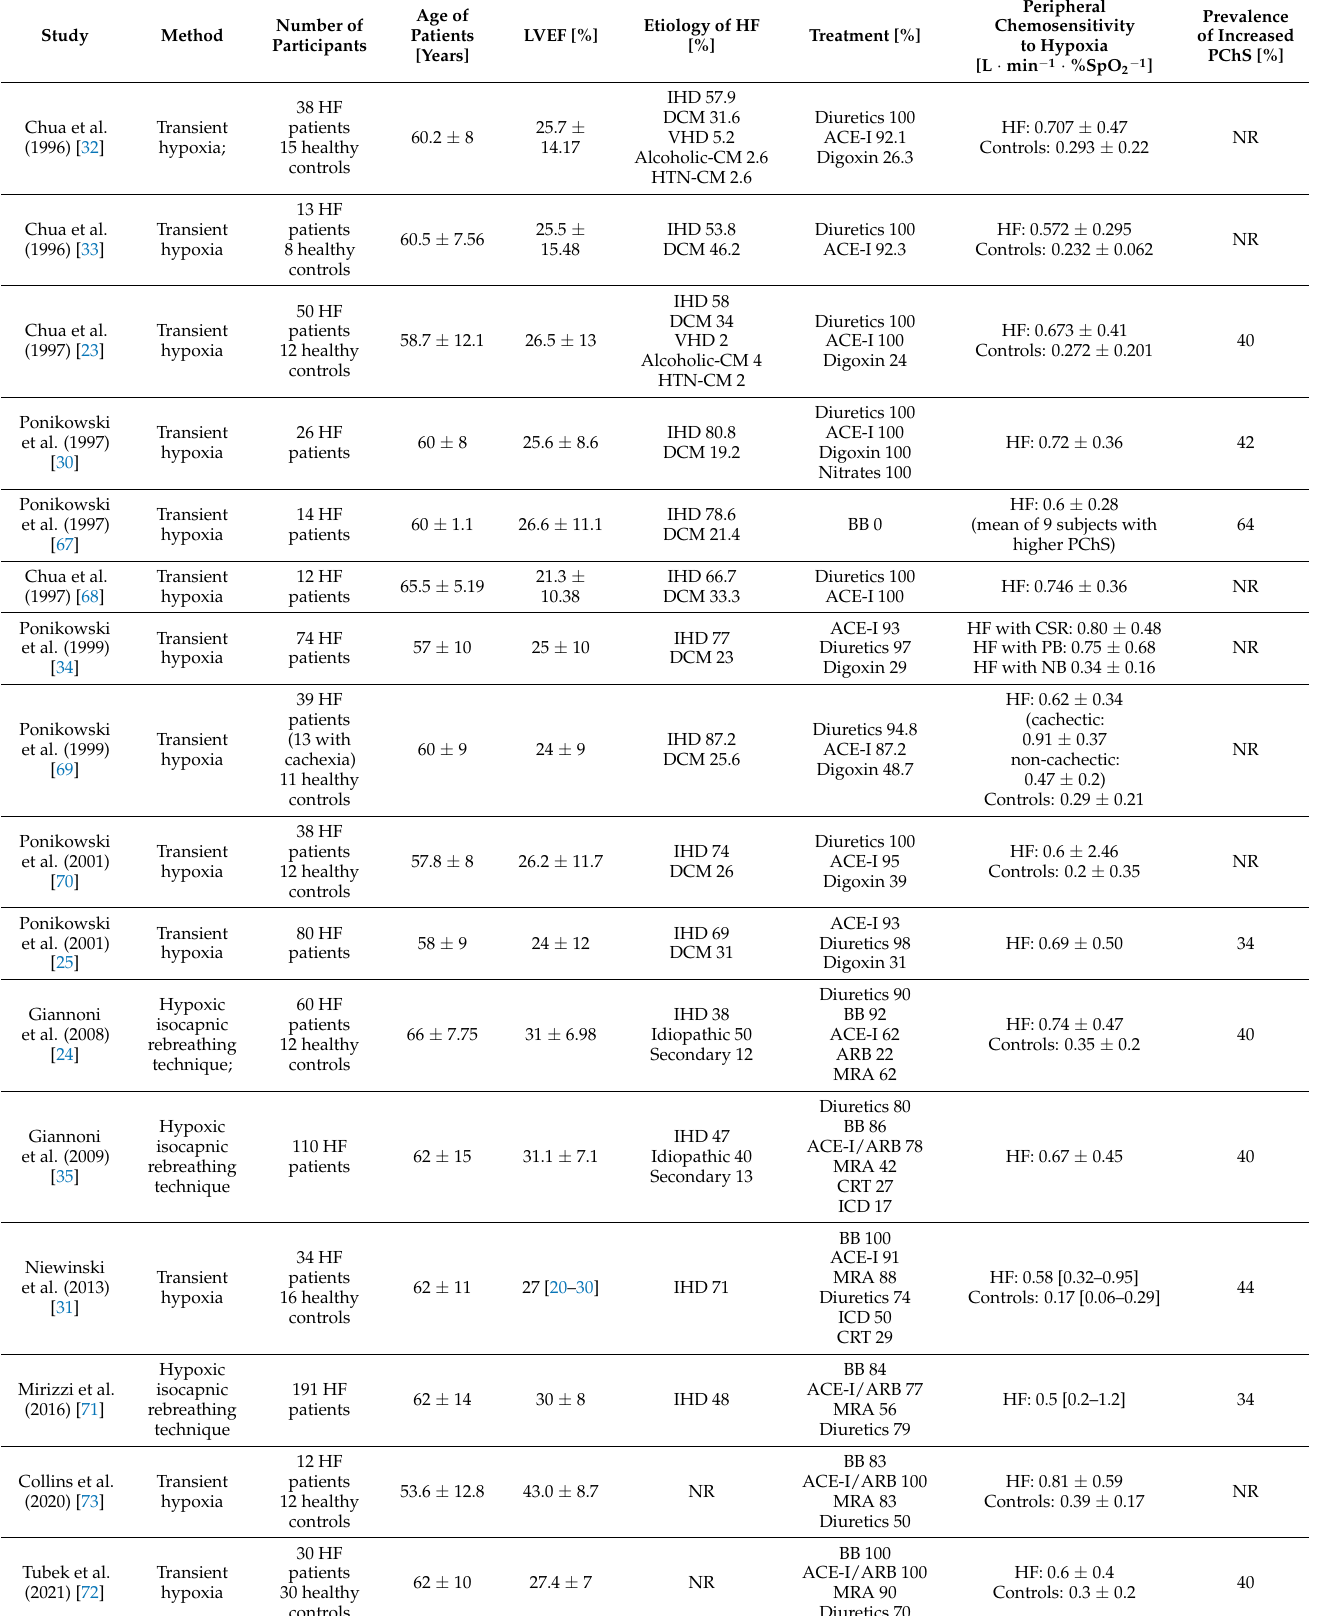
Table 1. Comparison of clinical studies with PChS assessment in HF